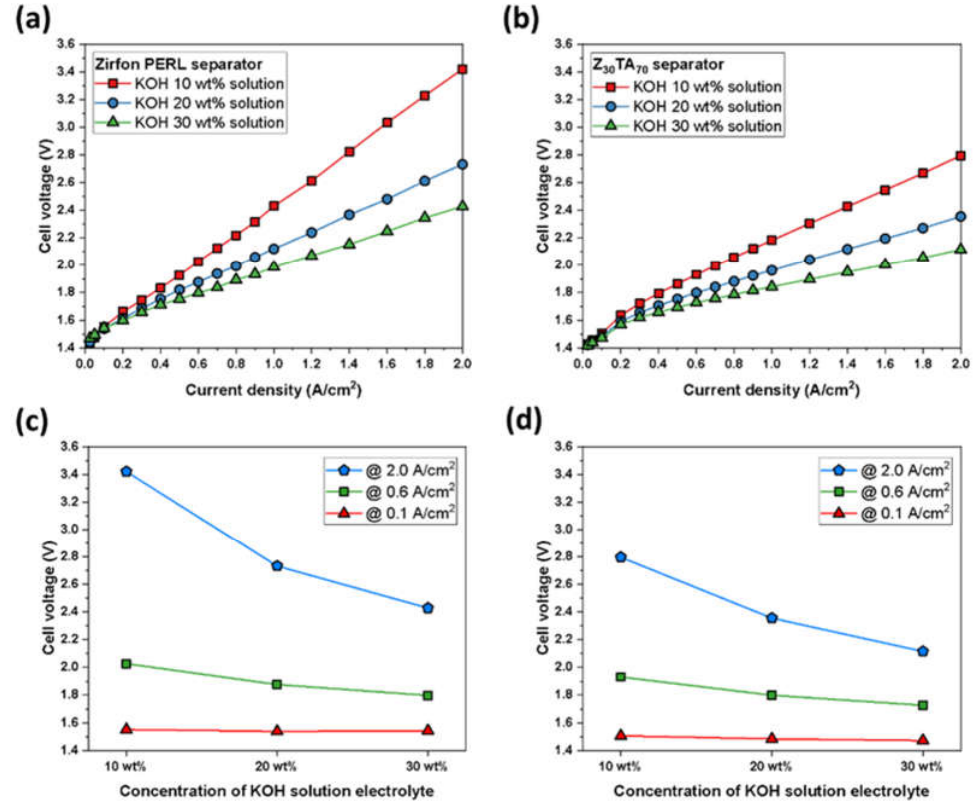
Figure 9. Polarization curves for an electrochemical cell using Raney nickel as the cathodic and Ni-Fe LDH as anodic electrode, respectively, in various KOH concentrations ( a ) Zirfon ® and ( b ) Z 30 TA 70 separator membrane. Effect of KOH concentration on cell voltage at different current densities, ( c ) Zirfon ® and ( d ) Z 30 TA 70 separator membrane.